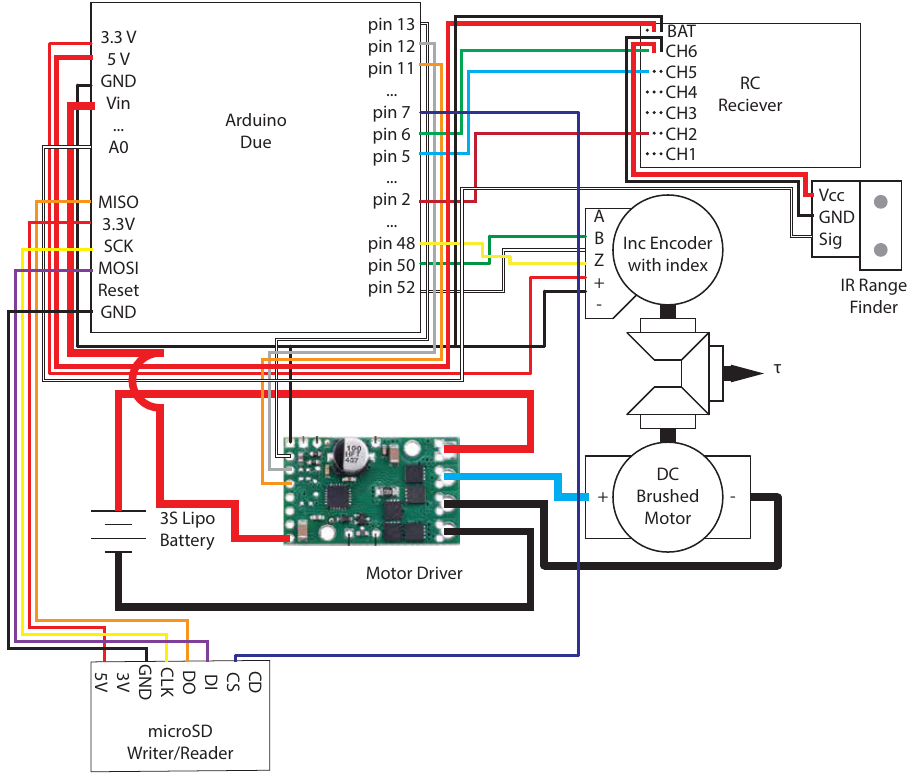
Figure 15. Electrical